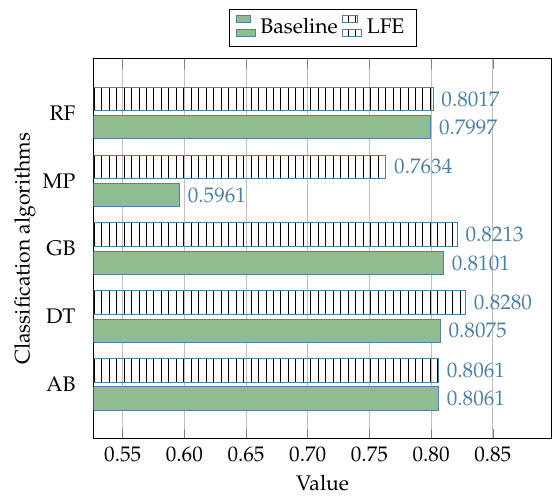
Figure 8. NSL-KDD dataset—MCC mean performance.